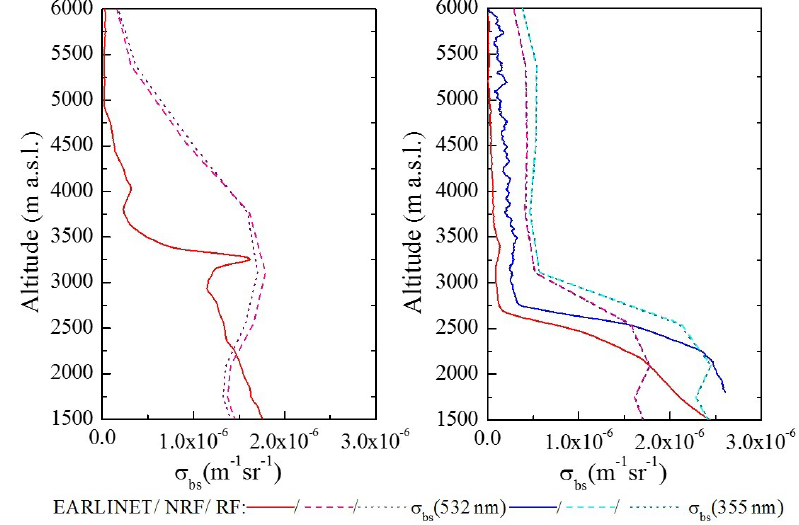
Figure 12. EARLINET (line), NRF (dashed line) and RF simulations (dotted line) of the backscatter coefficient at 532 and 355nm. For 6 July 2010 at 02:00UTC (left) and for 12 July 2010 at 13:00UTC